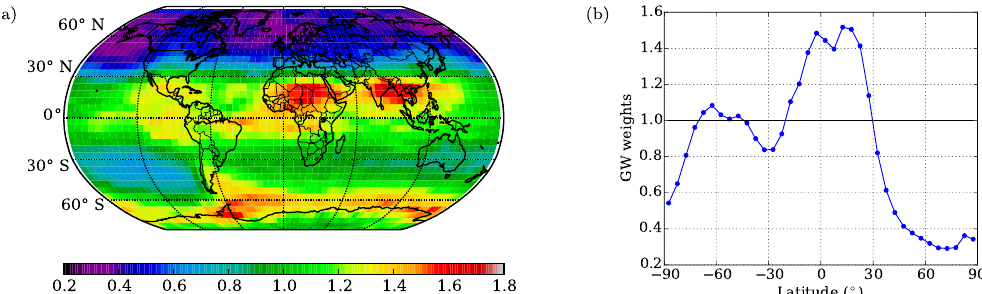
Figure 1. Horizontal field of GW weights (a) and their zonal means (b) . GW weights are derived from the field of potential energy (from GPS RO measurements) averaged over a vertical column of 25.0–34.9km altitude for the time interval 2007–2013. Then, each grid point is divided by the global mean value of potential energy for this vertical column. The grid is finally interpolated to the model